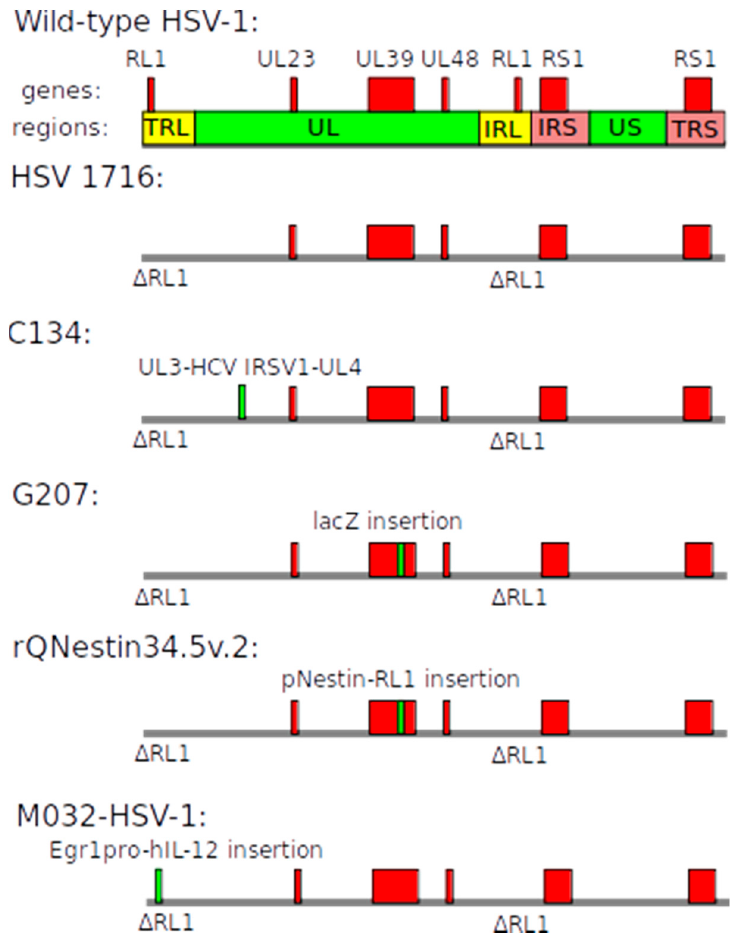
Figure 4. Schematic of the Herpes simplex virus 1 (HSV-1)-based vectors. The genome of wild-type HSV-1 can be divided into six regions which contain specific genes. Information about specific vectors is provided in the text.